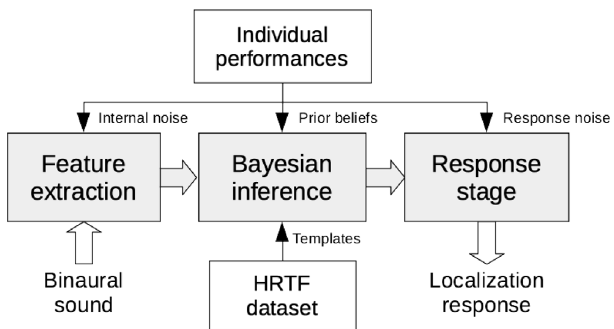
Figure 1. Model structure. Gray blocks: Model ’ s processing pipeline consisting of 1) the feature extraction stage to compute spatial features from the binaural sound; 2) the Bayesian inference stage integrating the sensory evidence obtained by comparison with feature templates and prior beliefs to estimate the most probable direction; and 3) the response stage trans- forming the internal estimate to the fi nal localization response. White blocks: Elements required to fi t the model to an individual subject consisting of listener performances in estimating sound direction and individual HRTF